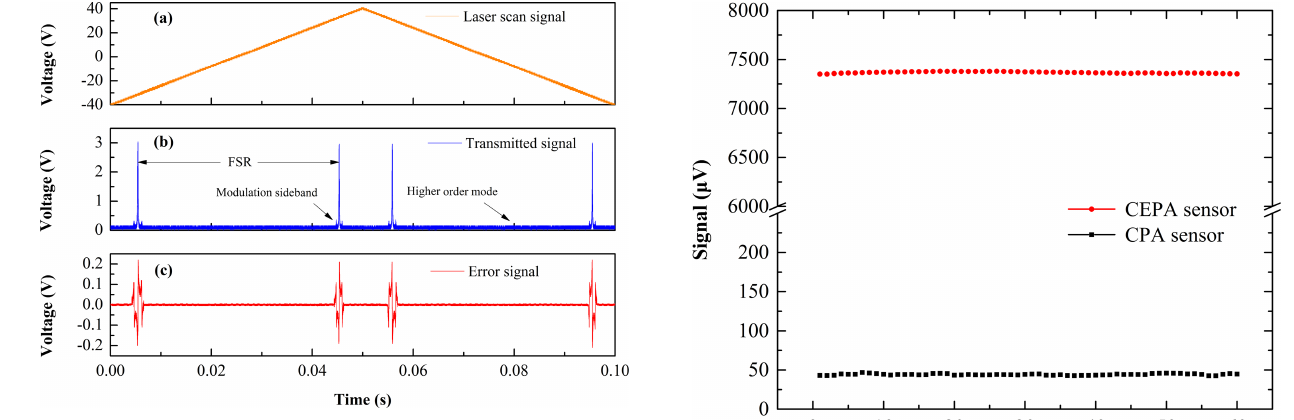
Figure 5. (a) Laser scan signal. (b) Transmitted signal from the cavity. (c) Error signal from the low-pass filter following the mixer.